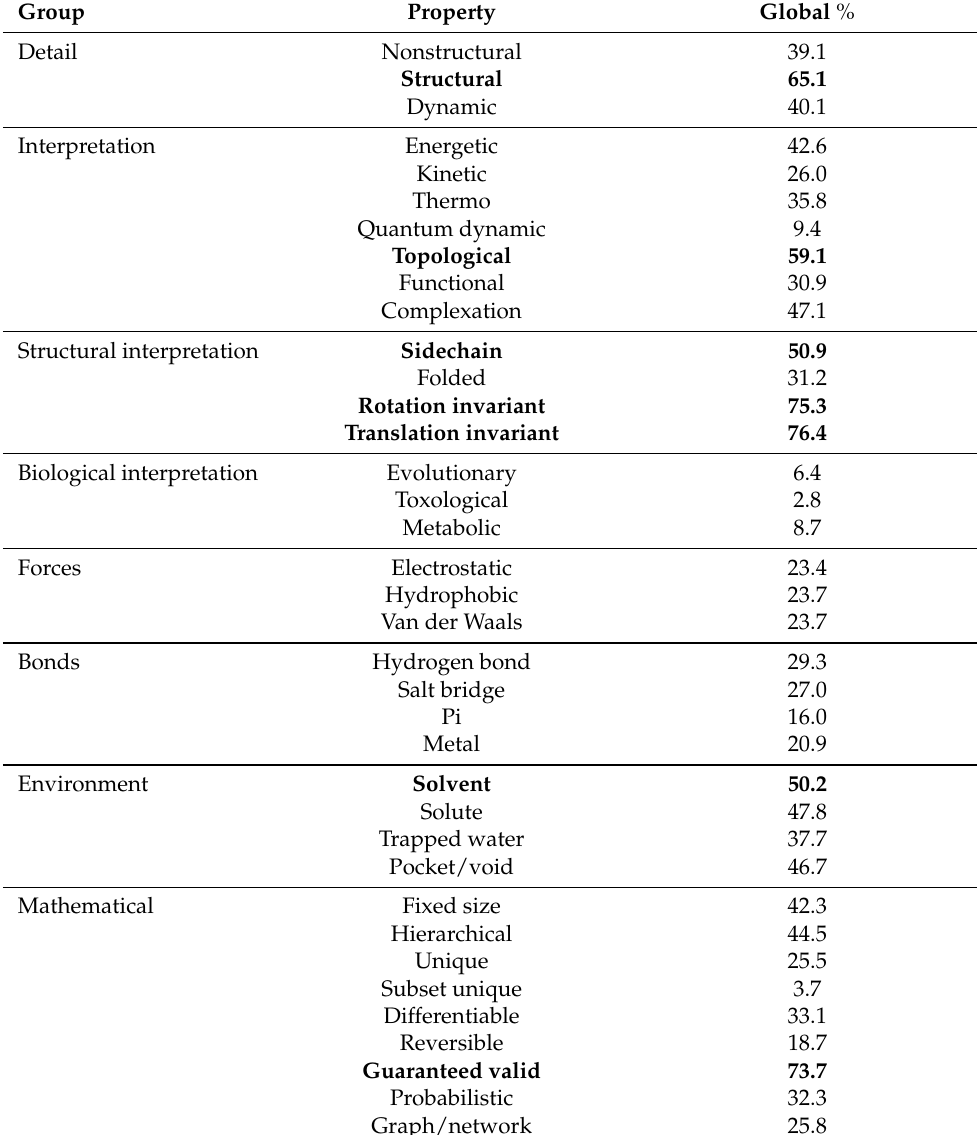
Table 1. Non-mutually exclusive property frequency across a sample of features grouped by detail, interpretation, structural interpretation, forces, bonds, environmental, and mathematical information. Properties satisfied by greater than fifty percent of features in the global dataset are